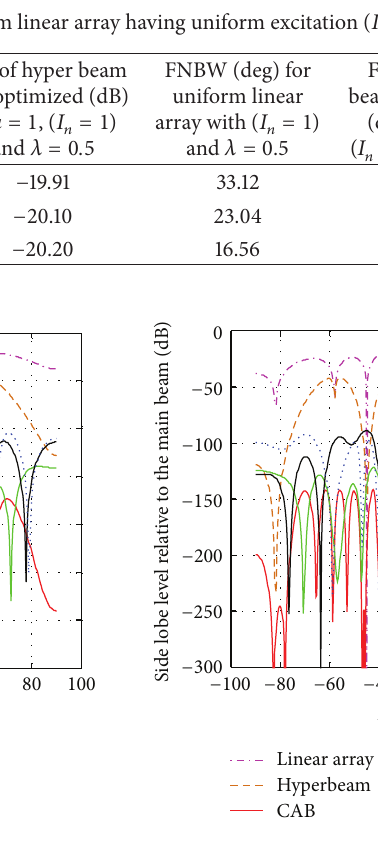
Figure 5: Best array pattern found by CAB for the 14-element array with improved SLL and FNBW at 𝑢 = 0.5 .